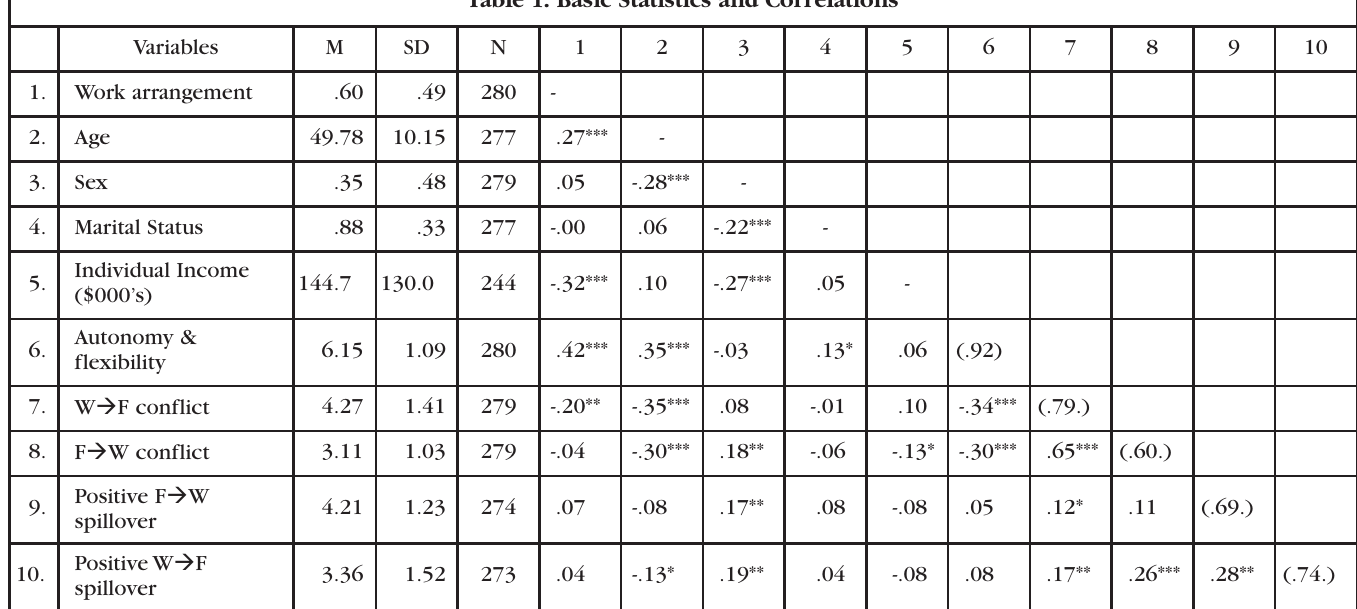
Table 1. Basic Statistics and